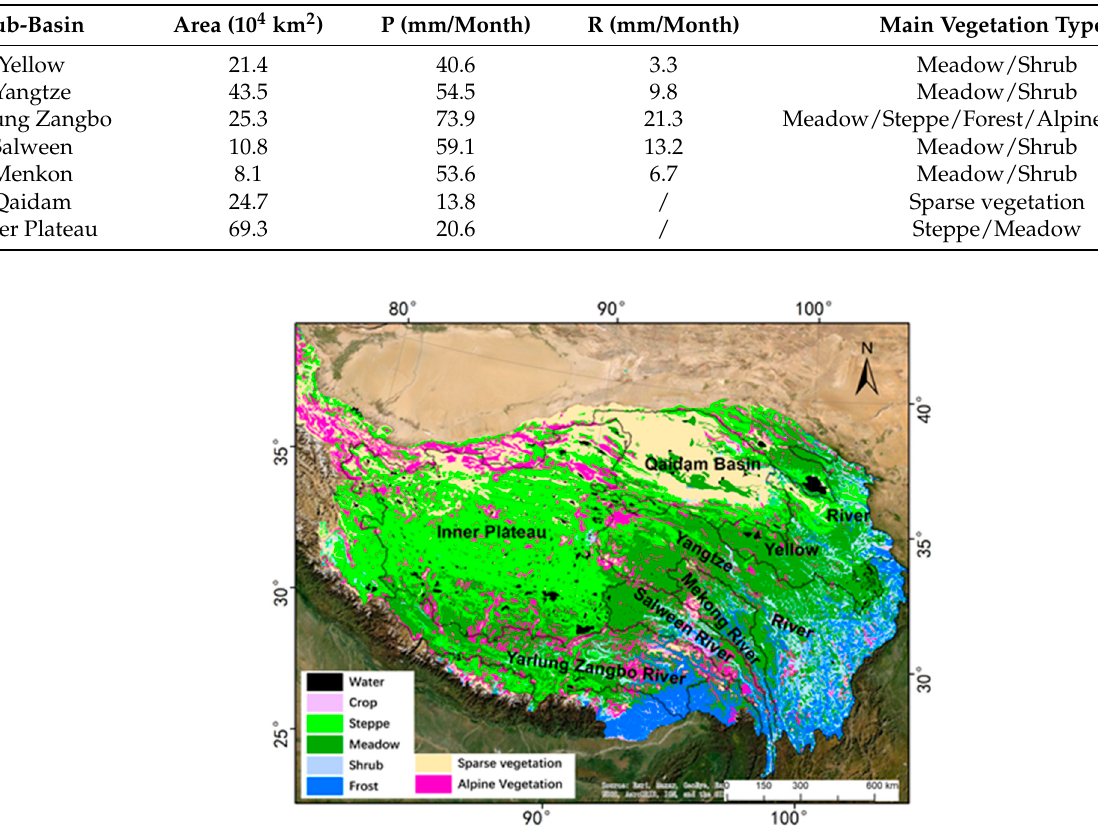
Figure 1. The sub ‐ basin distribution map of the Tibetan Plateau. Figure 1. The sub-basin distribution map of the Tibetan Plateau. Table 1. Overview of the seven sub-basins.